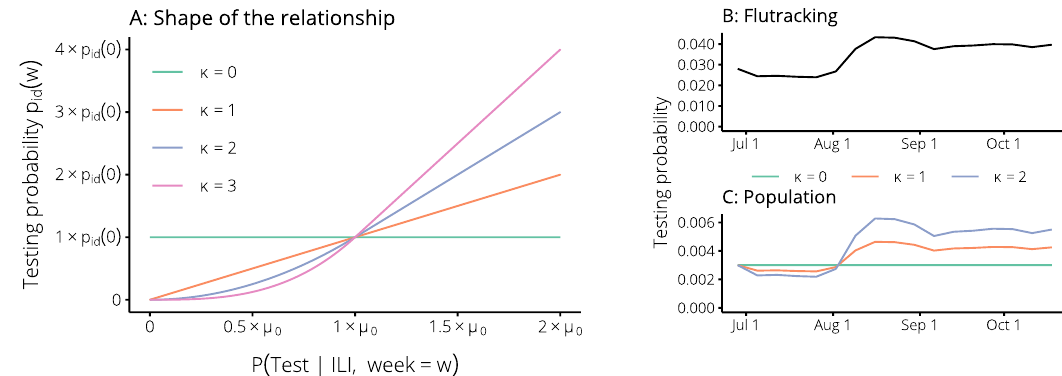
Figure 3. The testing probability p id ( w ) for the general population is a smooth function of the testing probability P ( Test | ILI, week = w ) obtained from the Flutracking data (panel A). Note